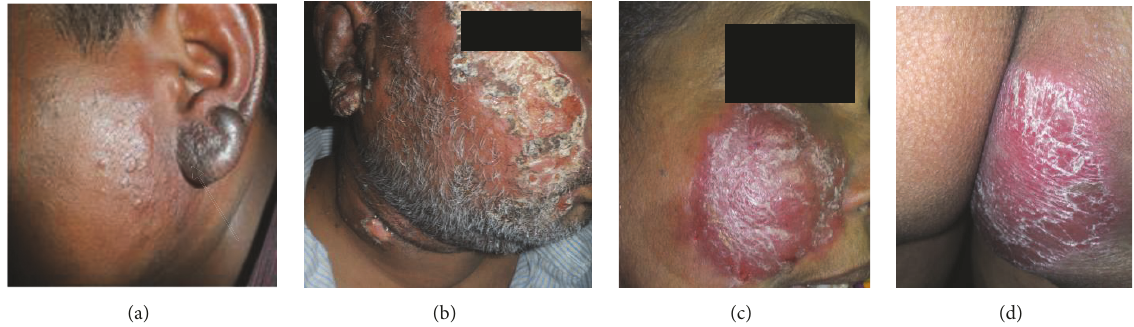
Figure 4: Atypical CL lesions observed in the study population. (a) Case 1, (b) case 2, (c) case 3-lesion I, and (d) case 3-lesion